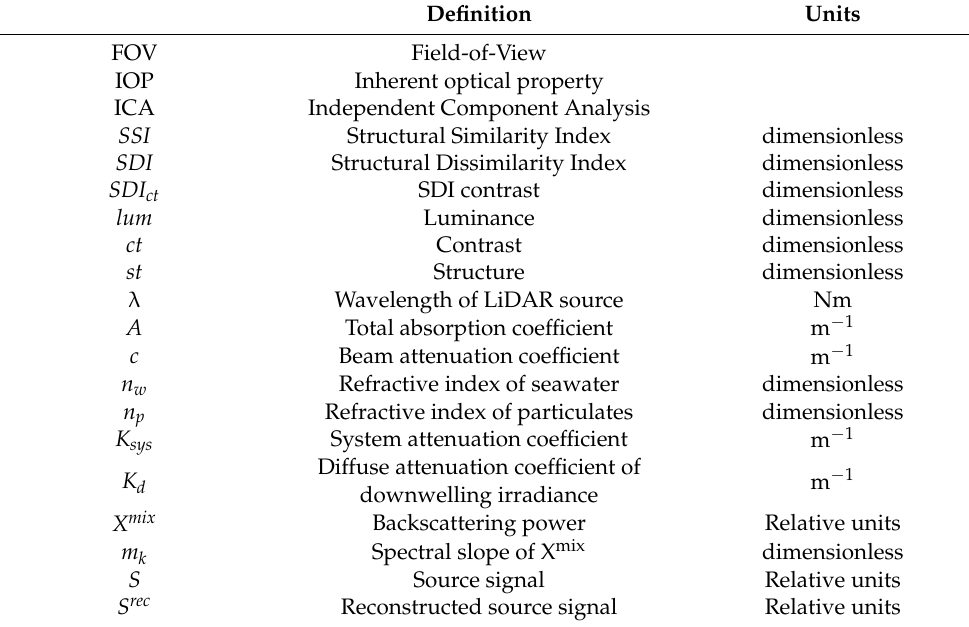
Table 1. Summary of